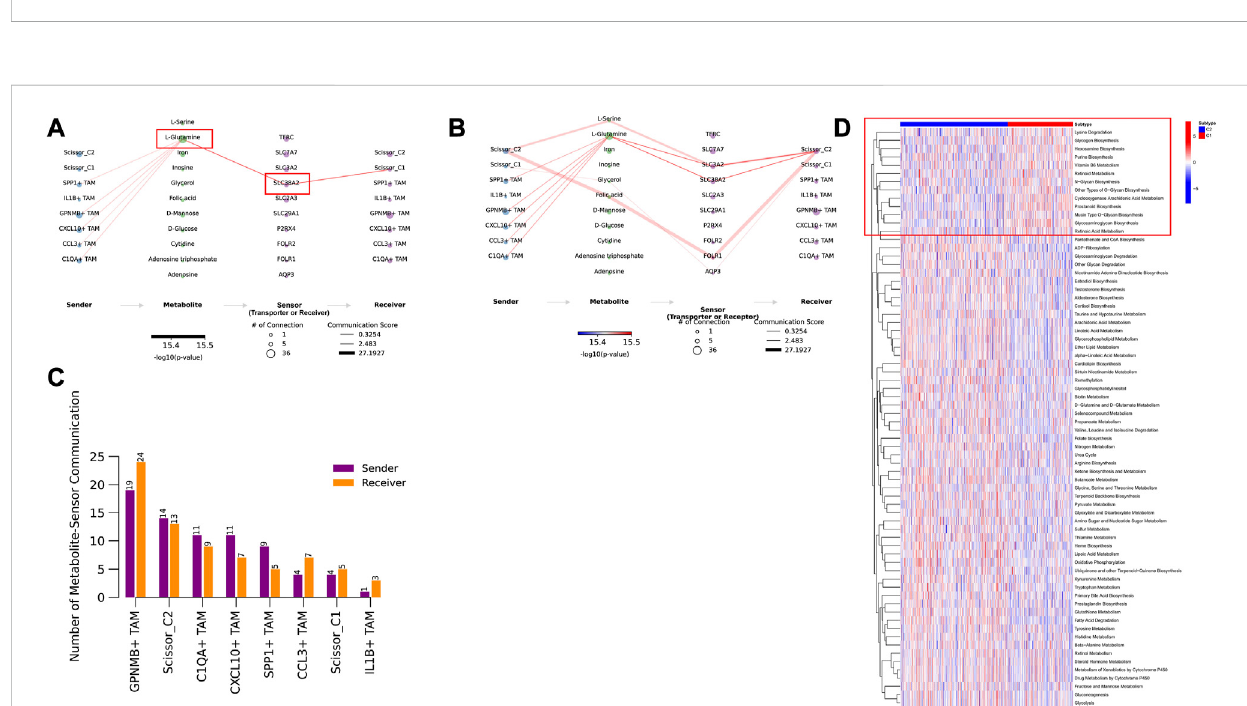
FIGURE 13 (A) TAMcellssecretingglutaminemetabolitesbindtotheSLC38A2transporterproteinonScissor_C1. (B) TAMcellssecretingglutaminemetabolites bind to SLC3A2 and SLC38A2 transporter proteins on Scissor_C2 cells. (C) Scissor_C2 is more active in metabolite-based communication with TAM compared to Scissor_C1. (D) Both C1 and C2 subtypes show signi fi cant differences in metabolic pathway activation, with C2 subtype showing signi fi cant metabolic pathway